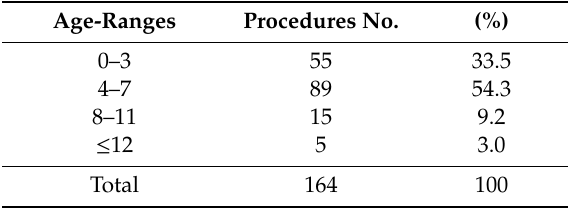
Table 1. Characteristics of the 22 patients (164 procedures).